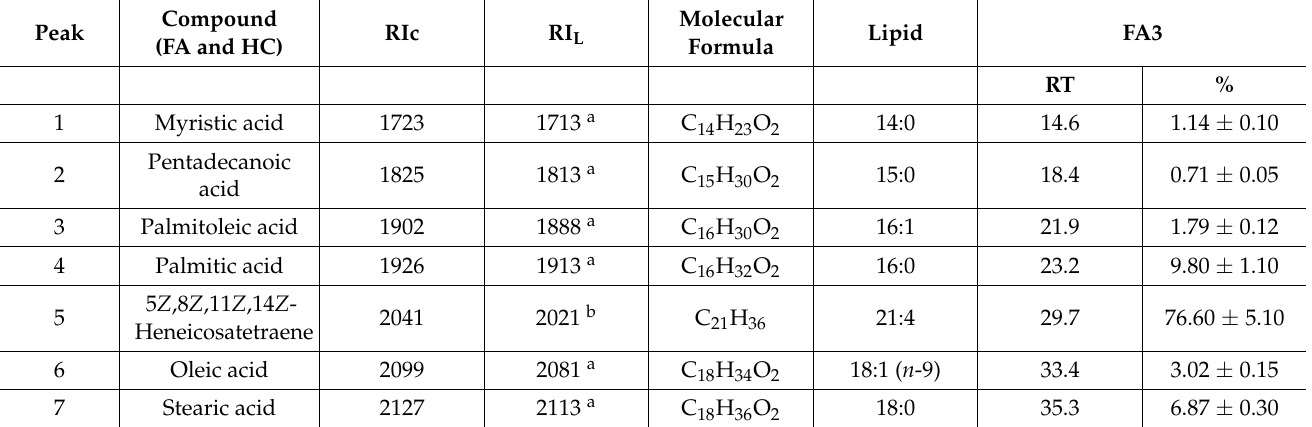
Table 1. Gas chromatography coupled to Mass Spectrometry (GC/MS) analysis of fatty acids (FAs) and hydrocarbons (HC) from P. gymnospora in the fraction FA3. RI = Retention index. The FAs identification was made comparing the mass spectrum of FAME FAs and the calculated